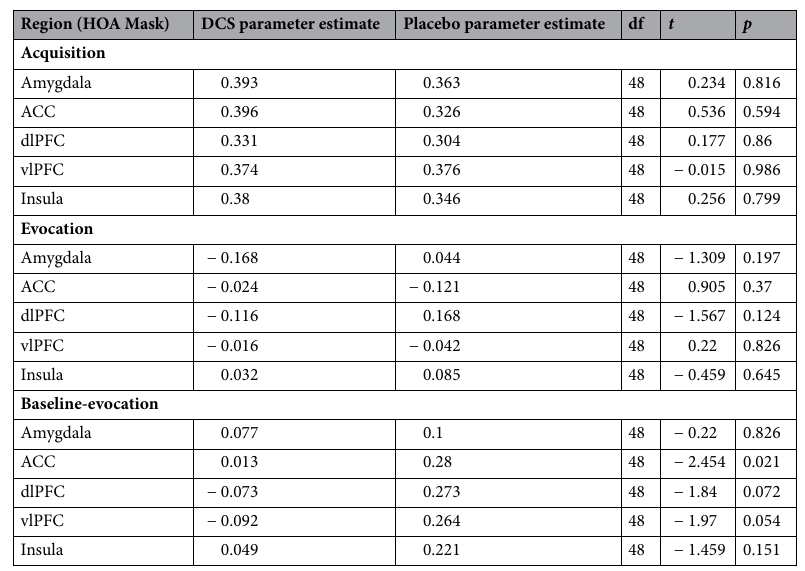
Table 4. Results of between-groups a priori ROI analyses for acquisition nocebo > control, and evocation nocebo > baseline high pain contrasts. With a Bonferroni correction for five ROIs, significant p values are < 0.01. HOA, Harvard Oxford Atlas; ACC, anterior cingulate cortex; dlPFC, dorsolateral prefrontal cortex; vlPFC, ventrolateral prefrontal